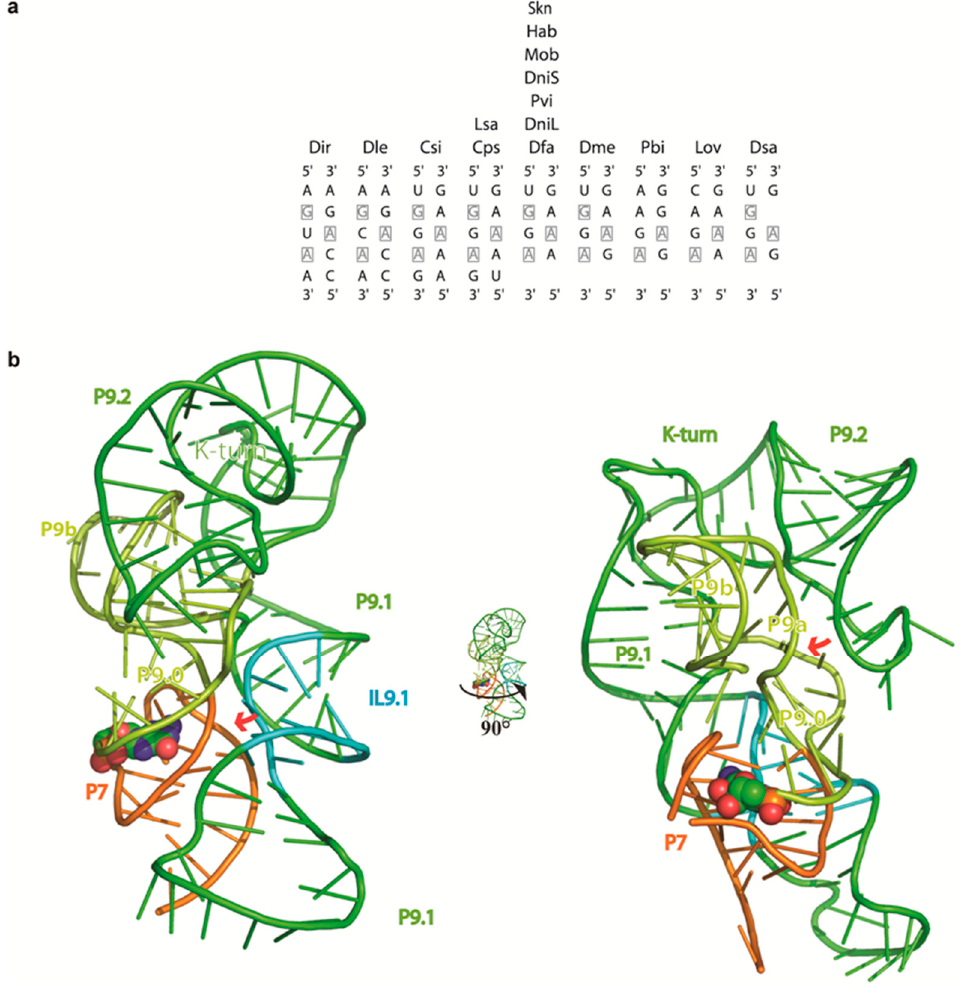
Figure 5. Structural analysis of the P9 domain. ( a ) Sequence structure of the internal loop in P9.1 in 16 sequences of group IE introns. Most sequences show a symmetrical internal loop containing two nucleotides fully conserved and a third one conserved in all but two sequences (Pbi, Lov). These nucleotides (boxed) may be important in the structuring of the loop and/or in its ability to interact with P7. A list of the introns can be found in Supplementary Materials Figure S3; ( b ) Ribbon 3D model showing how the internal loop of P9.1 is thought to be involved in stabilizing P7 (red arrow in left panel) and P9.2 is involved in stabilization of P9.0 (red arrow in right panel), respectively. The internal loop (IL9.1) of P9.1 is depicted in cyan, P7 in orange, P9.0, P9a and P9b in lime green, P9.1 and P9.2 in green. ω G is represented as an atom model with colouring according to atom type (CPK). Pb 2+ cleavage and in-line probing data show different patterns in the P9.2 region of the L-IVS as compared to the FLC (Supplementary Materials Table S2). The 3 ′ end of L9.2 is unreactive but the 5 ′ end is strongly cleaved in in-line experiments at position G311 in both RNA species. Moreover, the A307 to A309 nucleotides are significantly less reactive in the FLC than in the L-IVS where this trend